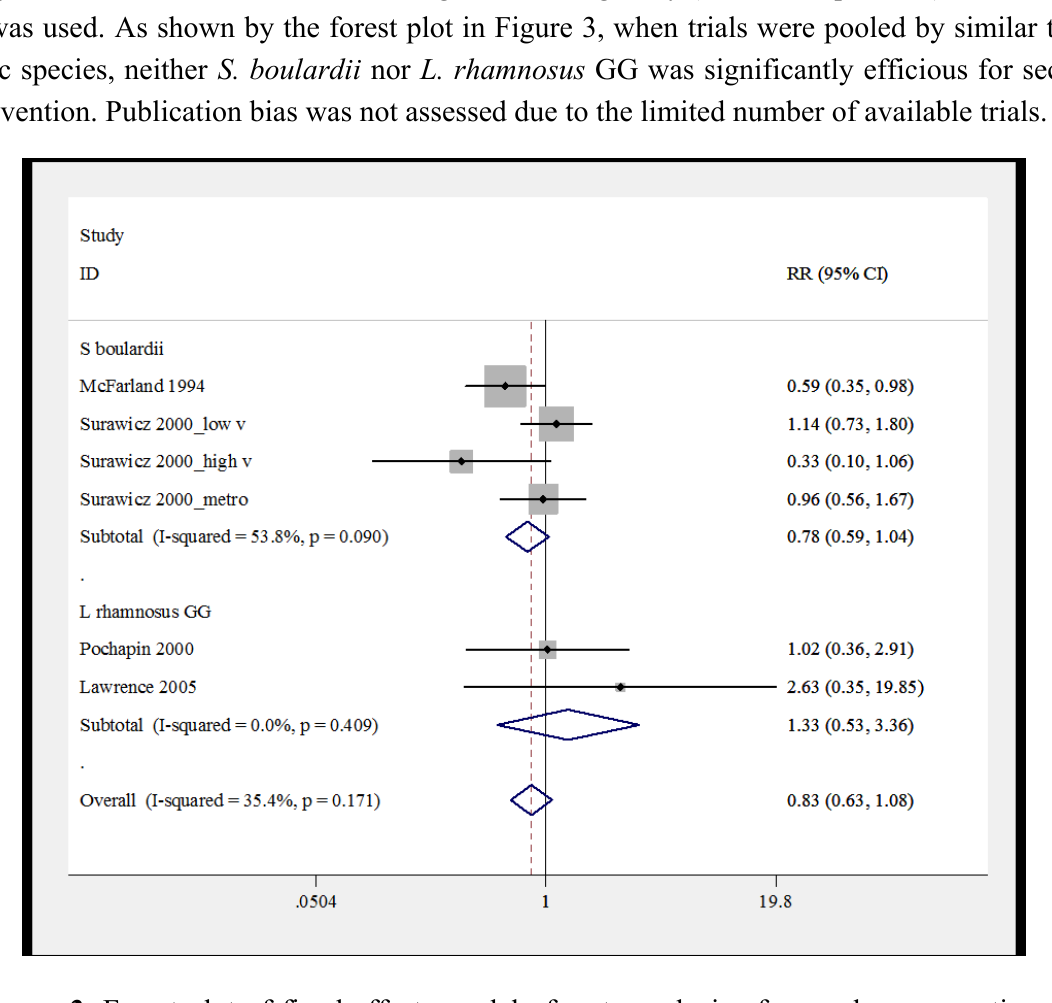
Figure 3. Forest plot of fixed effects model of meta-analysis of secondary prevention of C. difficile disease by sub-group of probiotic type, x-axis indicates relative